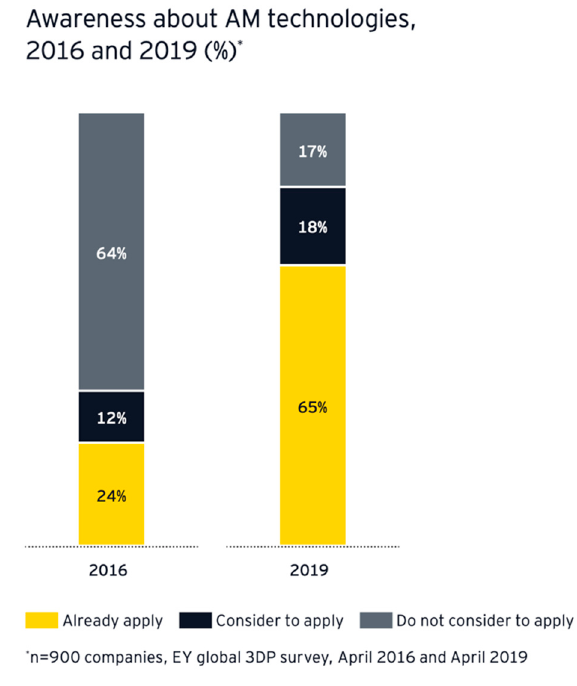
Figure 7. Awareness about AM technologies [33].